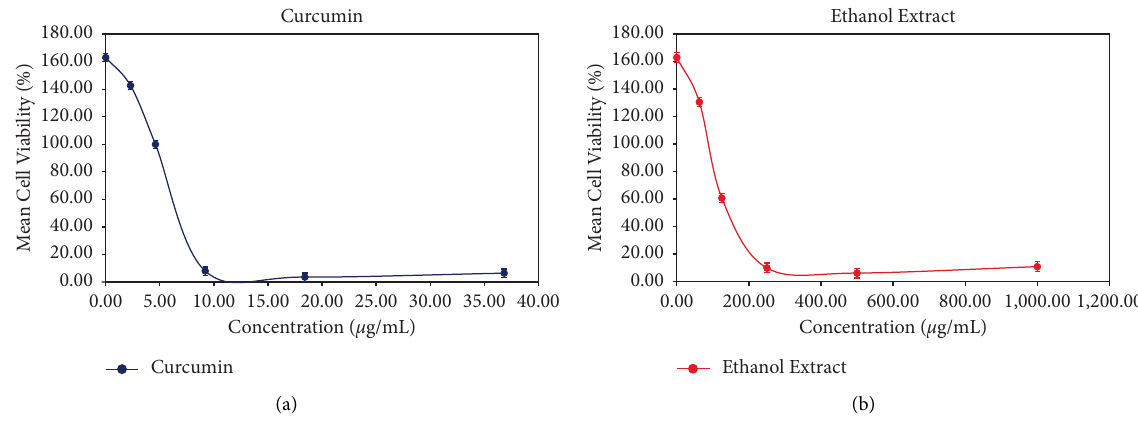
Figure 1: (a) Cytotoxicity of curcumin at various concentrations. (b) Cytotoxicity of ethanol extract of C. nioroense at various concentrations. Table 3: Mean zones of growth inhibition (ZI) of ethanol and petroleum ether extracts of C. nioroense against test organisms. Sample/drug